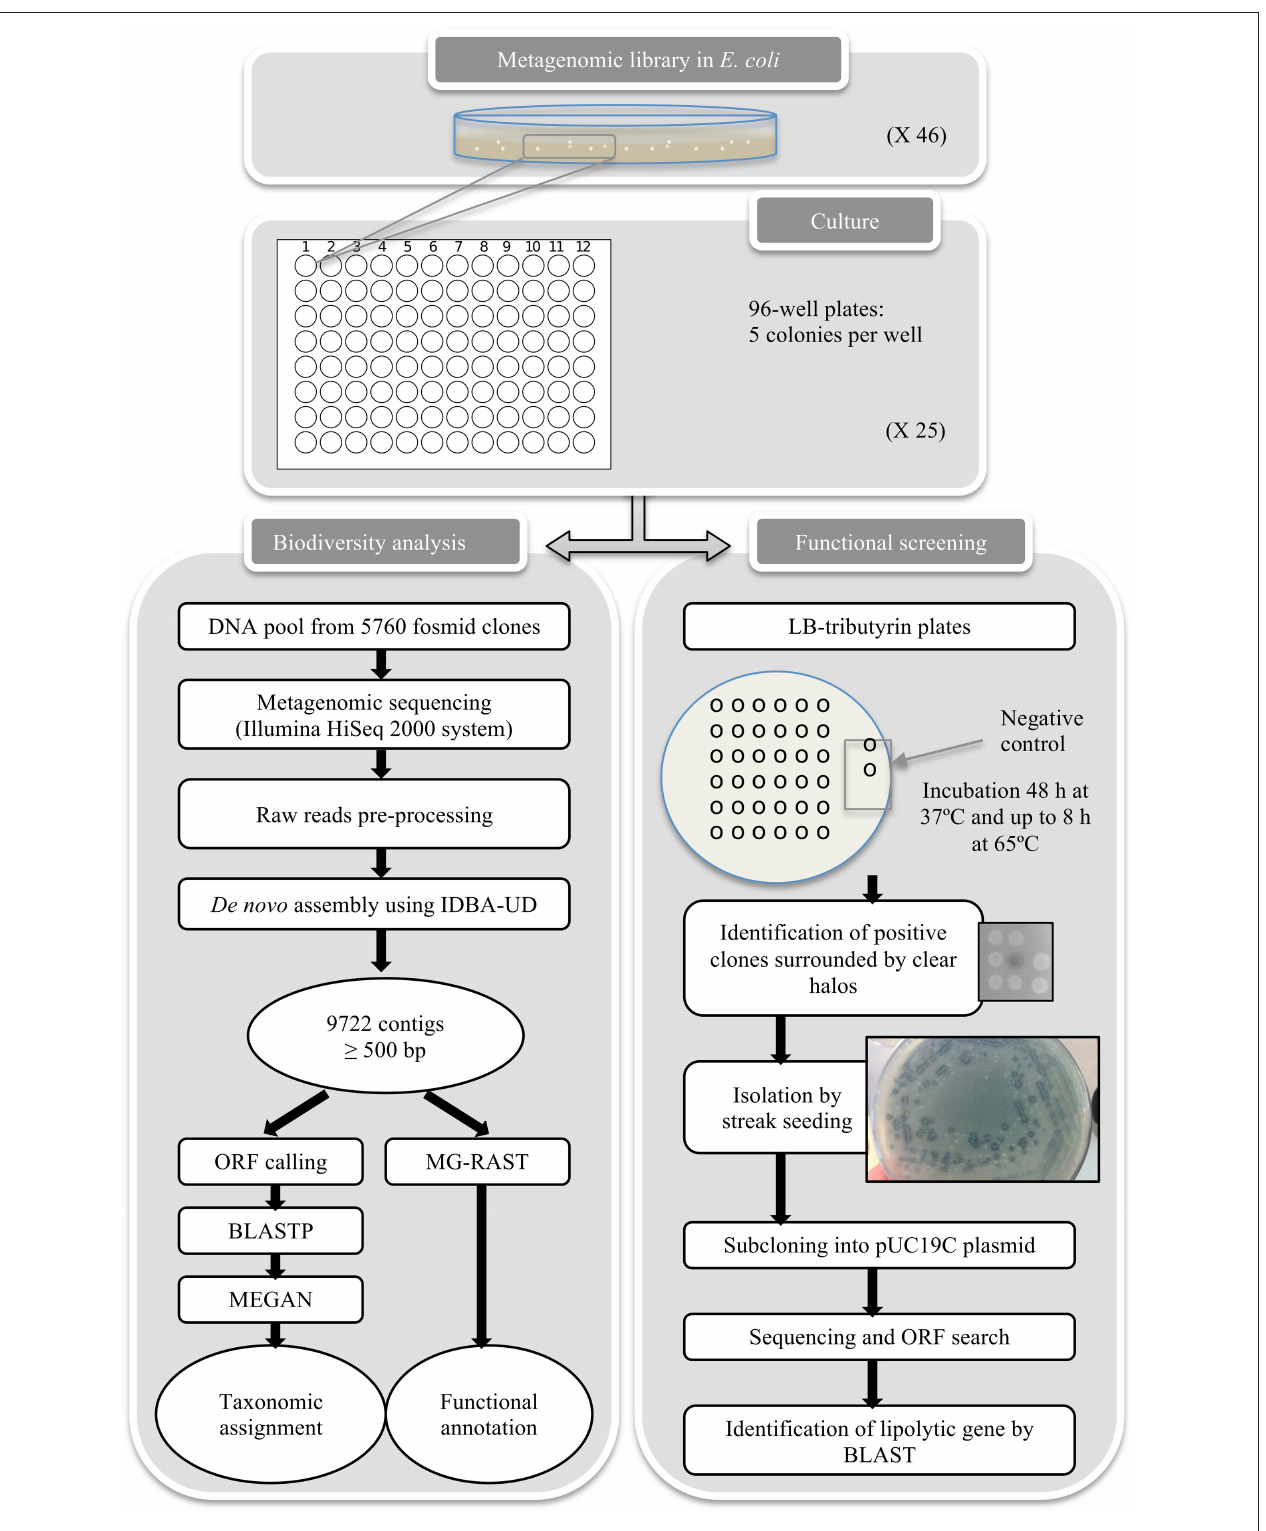
FIGURE 1 | A flowchart showing the steps of the functional screening procedure and bioinformatic analysis.